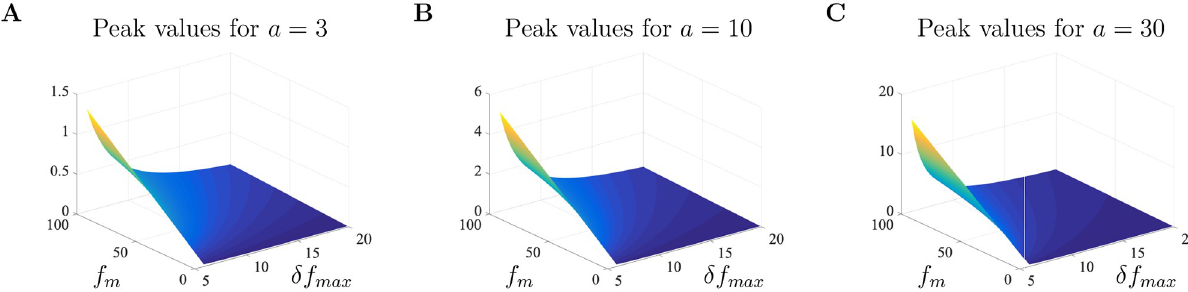
Fig 14. Peak values as a function of scaling parameters. Peak values of the data conversion as a function of f m and δ f max for a = 3 A , a = 10 B , and a = 30 C . In all simulations, R f = 100, KD = 0.3, and c 0 = 0.05 were fixed. This figure shows that the greatest scaling affects occur when f m and δ f max are large and small, respectively.